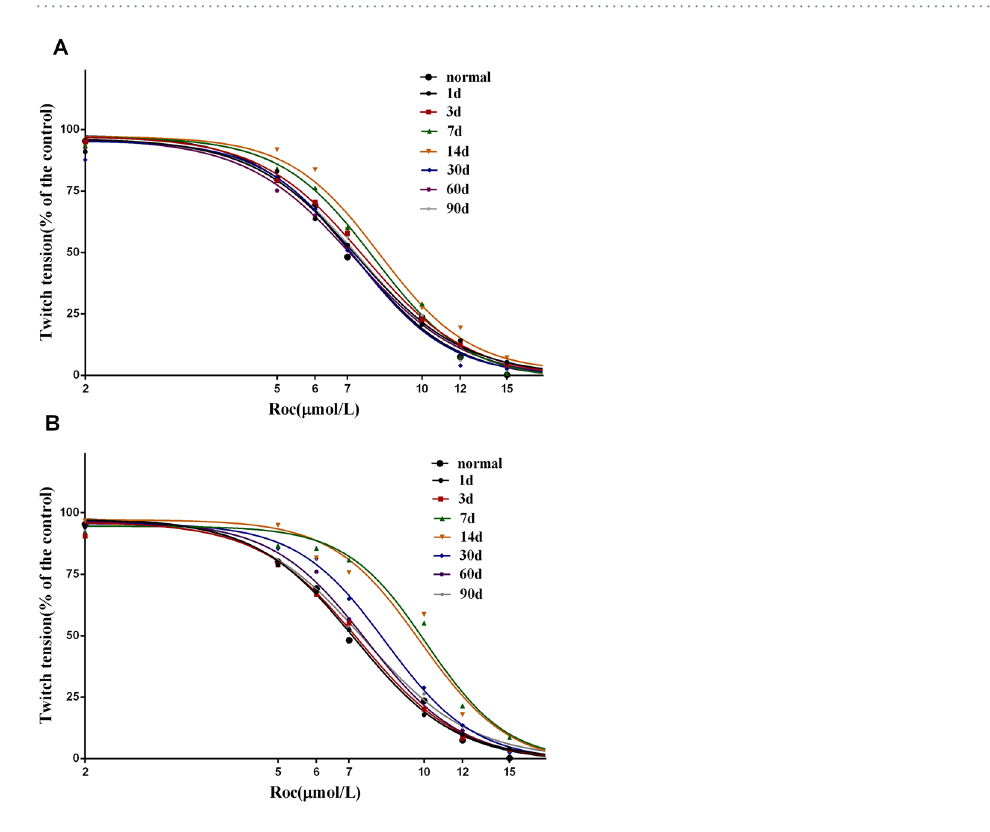
Figure 3. Rocuronium dose-response curves for ( A ) the DIII (grade III) injury and ( B ) DIV (grade IV) injury groups. Values are